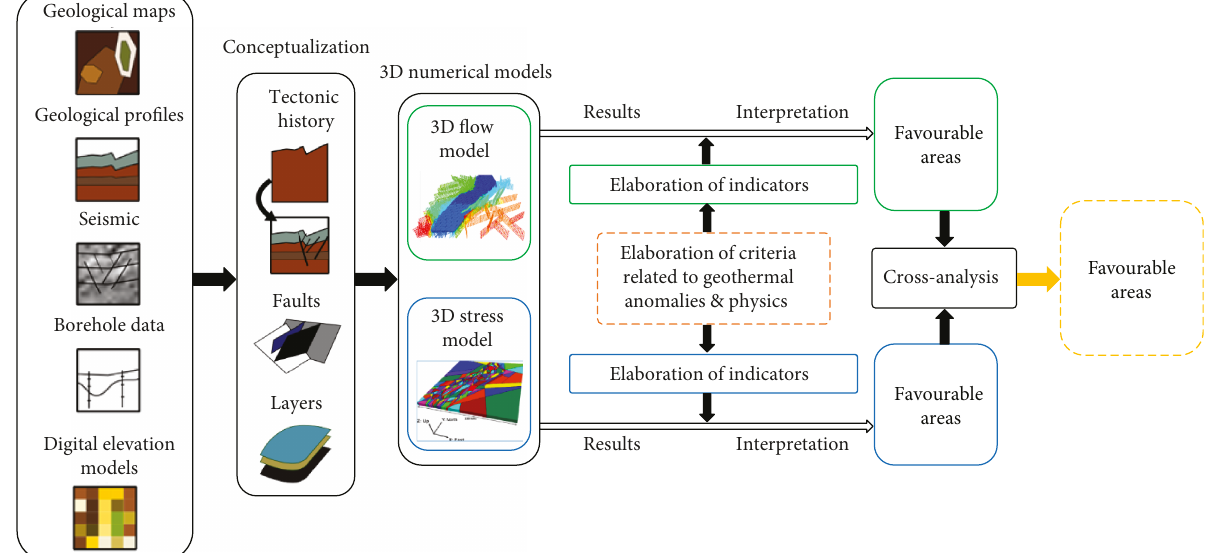
Figure 12: Methodology employed to delineate preferential target areas for geothermal resources using numerical